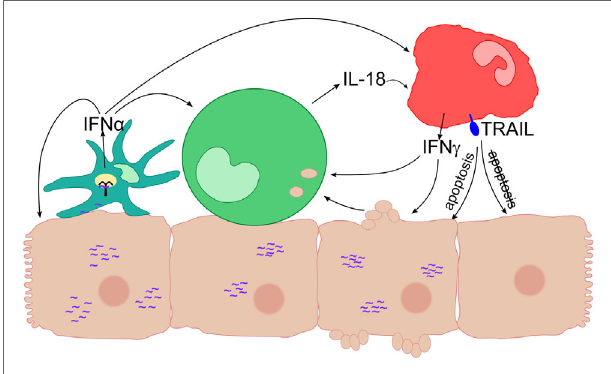
FigUre 8 | Interaction of different innate immune cells in response to hepatitis C virus subgenomic replicon subgenomic replicon (HCV SGR) cells. Schematic overview of the interactions of innate immune cells leading to anti-viral responses like secretion of interferons (IFNs) and expression of TRAIL. A plasmacytoid dendritic cells (pDC) is depicted in cyan, a monocyte in green, a natural killer (NK) cell in red, viral RNA in purple, and TLR7 inside the pDC in